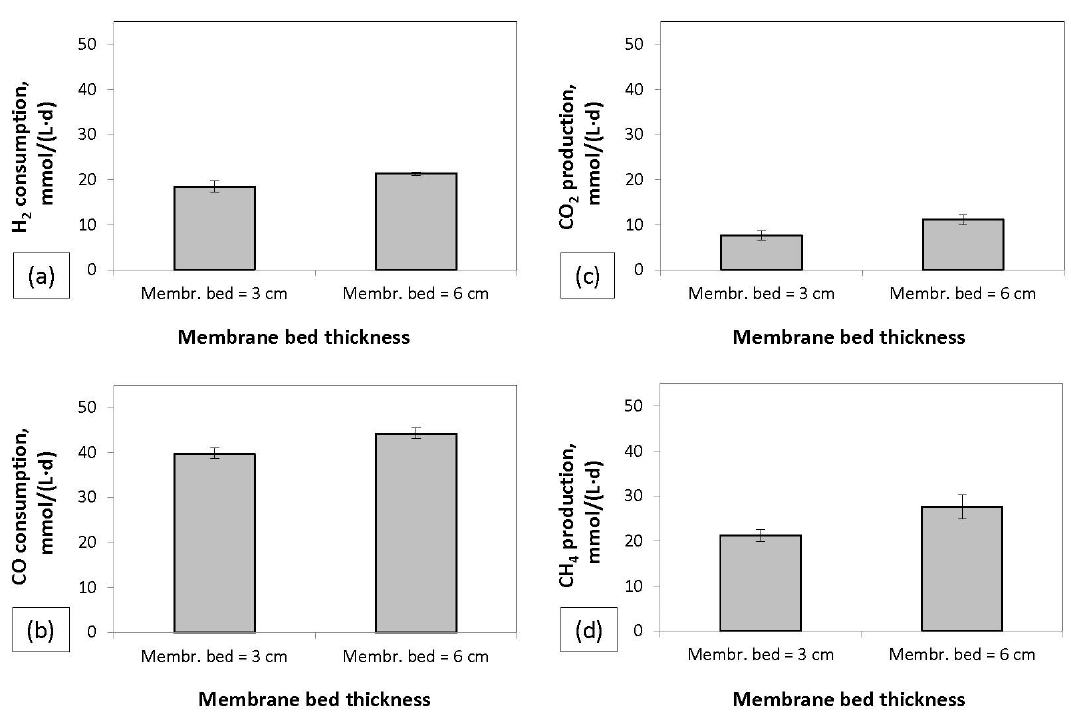
Figure 5. Syngas biomethanation in floating MBR and floating MBR.2 with a membrane bed thickness of 3 cm and 6 cm, respectively, during continuous syngas feeding. Consumption of ( a ) H 2 and ( b ) CO and production of ( c ) CO 2 and ( d ) CH 4 in mmol/(L · d).